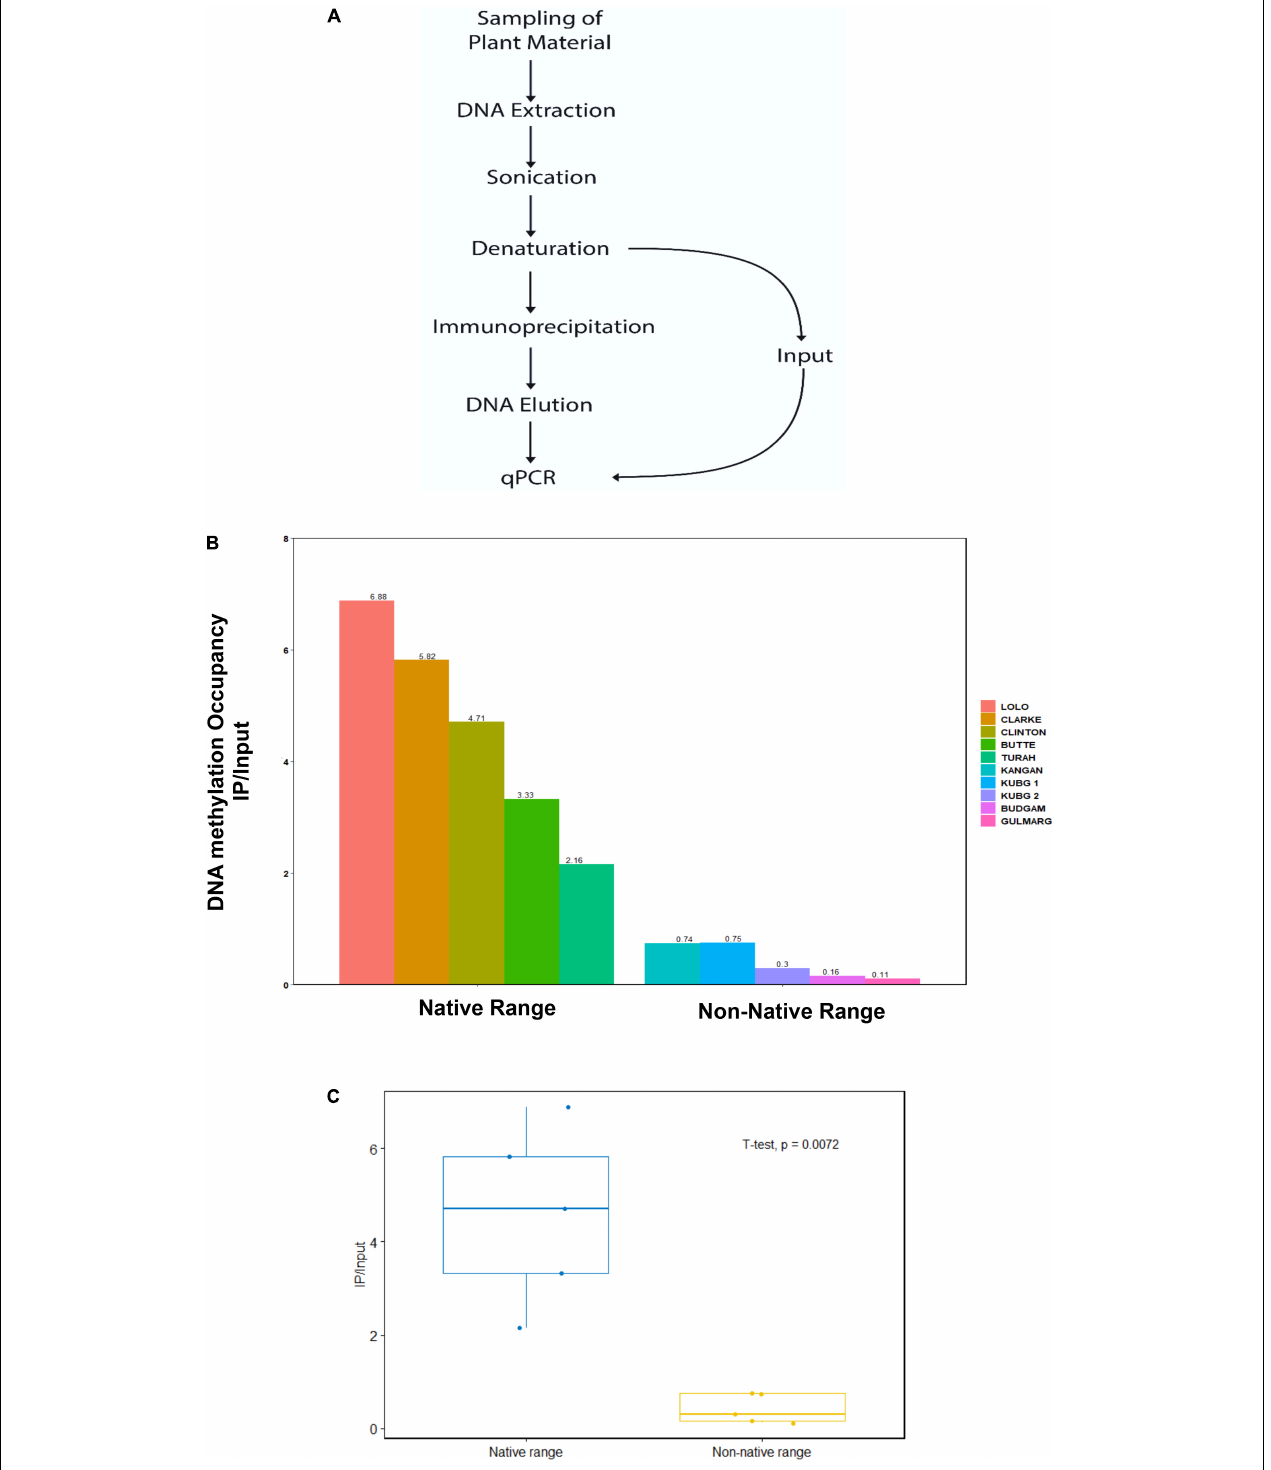
FIGURE 1 | DNA methylation levels at ABC transporter gene in the native (North America) and non-native (Kashmir Himalaya) range plants. (A) The plant material was collected at different geographical locations as mentioned in “Materials and Methods” section. The DNA was isolated, sonicated, and subjected to immunoprecipitation using an antibody against 5-methyl cytosine and subjected to PCR with specific primers. (B) The IP/input ratio for 5-methyl cytosine in DNA of native and non-native range plants across different sites at ABC transporter gene. (C) The IP/input values at ABC transporter gene in native and non-native range obtained using R software, n =